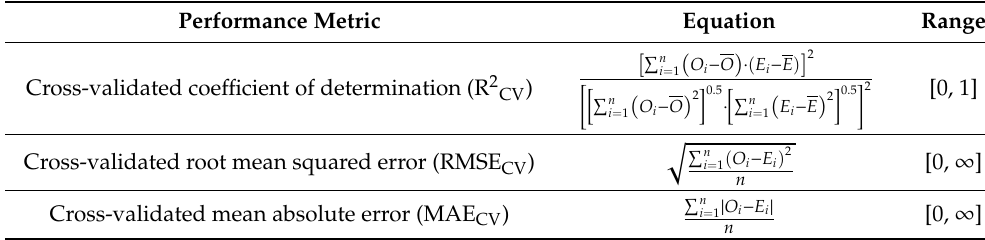
Table 1. Performance